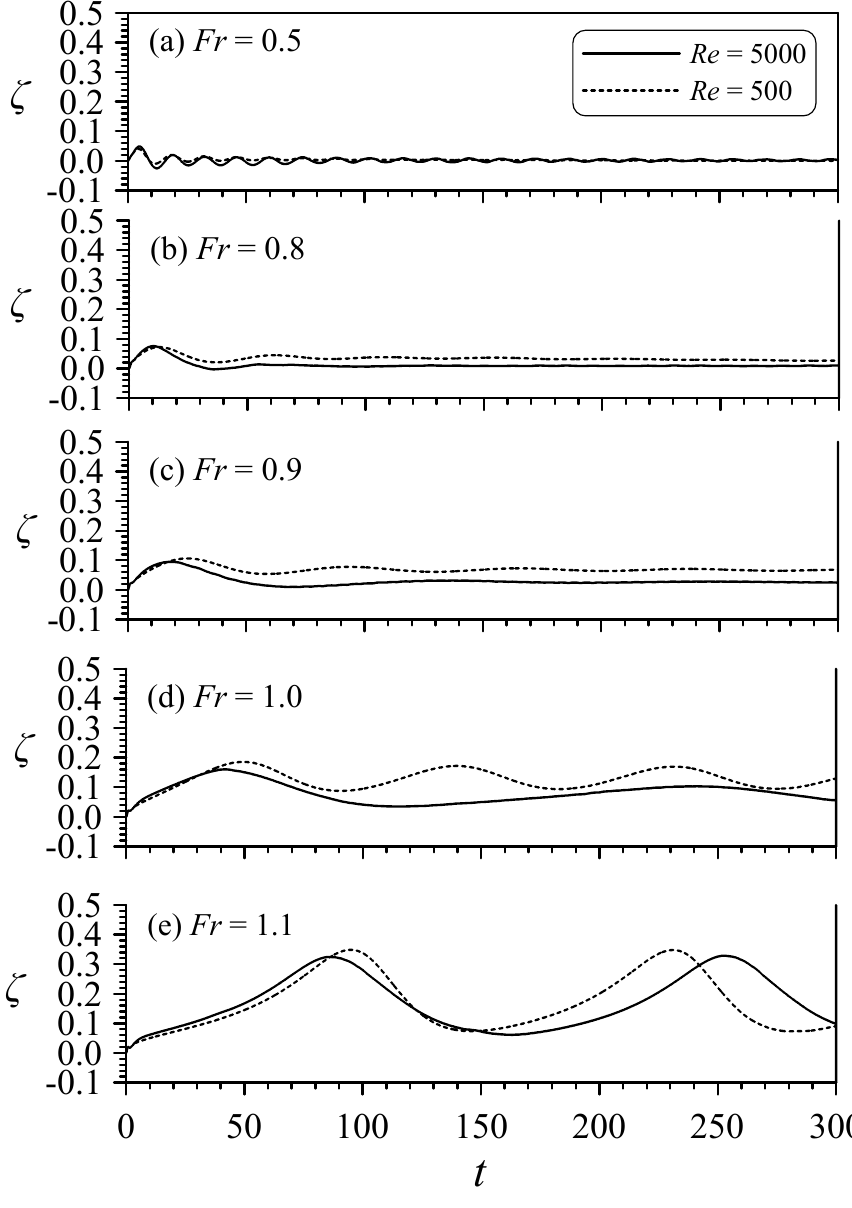
Figure 13. Time varying free-surface elevations at x = − 0.5 for Re = 5000, 500, and at various Fr : ( a ) Fr = 0.5, ( b ) Fr = 0.8, ( c ) Fr = 0.9, ( d ) Fr = 1.0, and ( e ) Fr = 1.1.